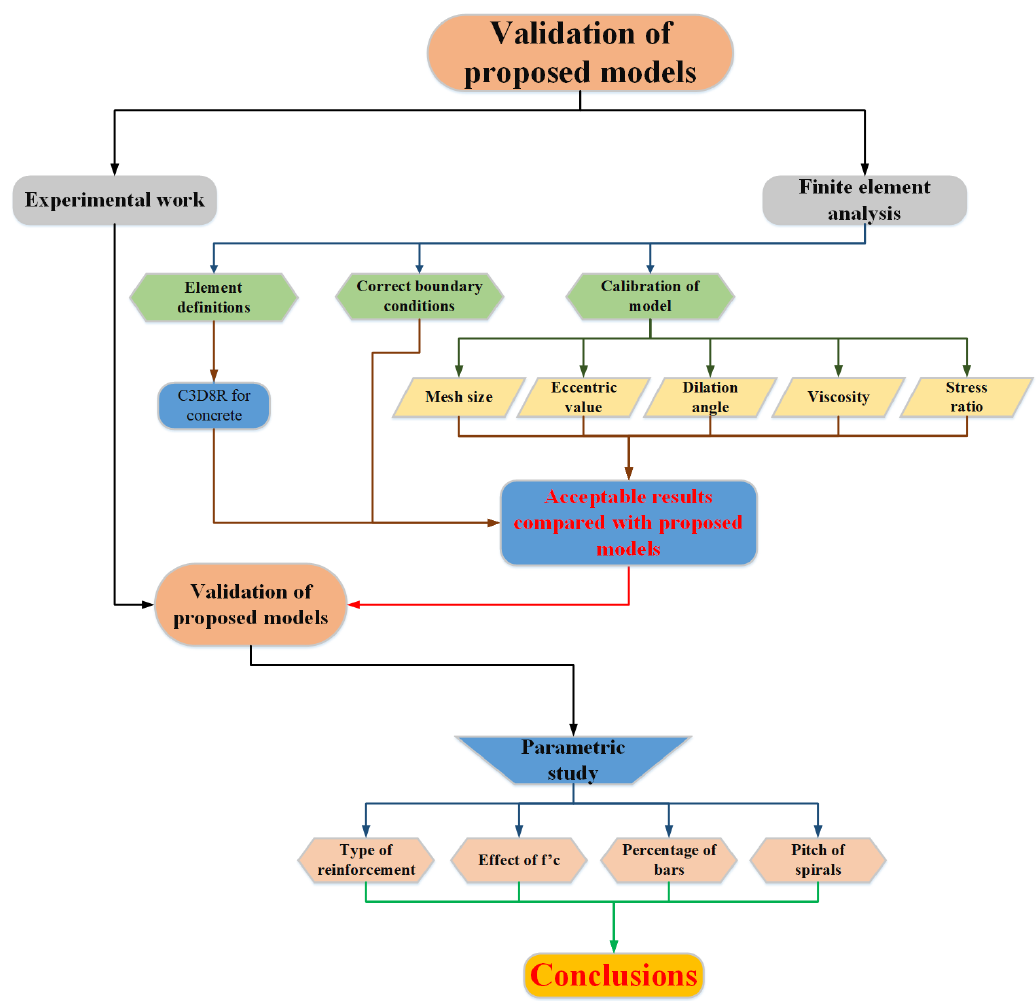
Figure 6. Flow chart of the FEA calibration and parametric study.